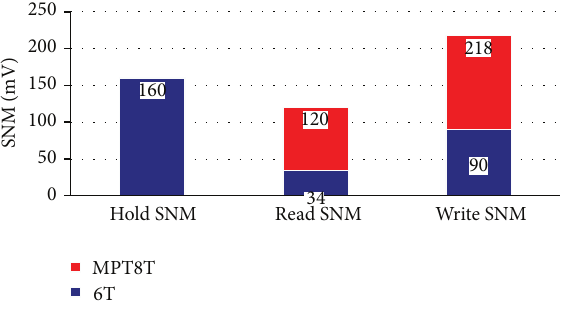
Figure 17: Comparative SNM graph of MPT8T and 6T.